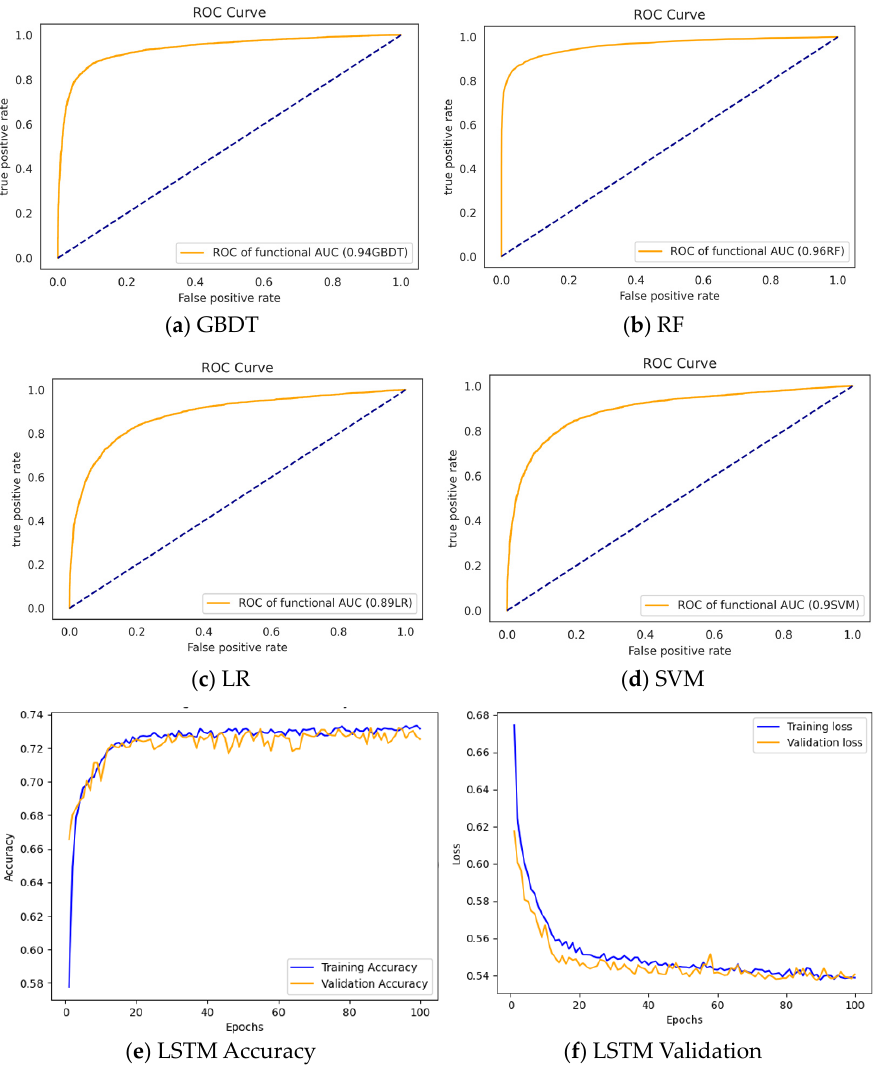
Figure 3. Evaluation of different models using ( a – d ) ROC curve of the classifiers trained using the full features. ( e , f ) Training vs. validation loss LSTM.